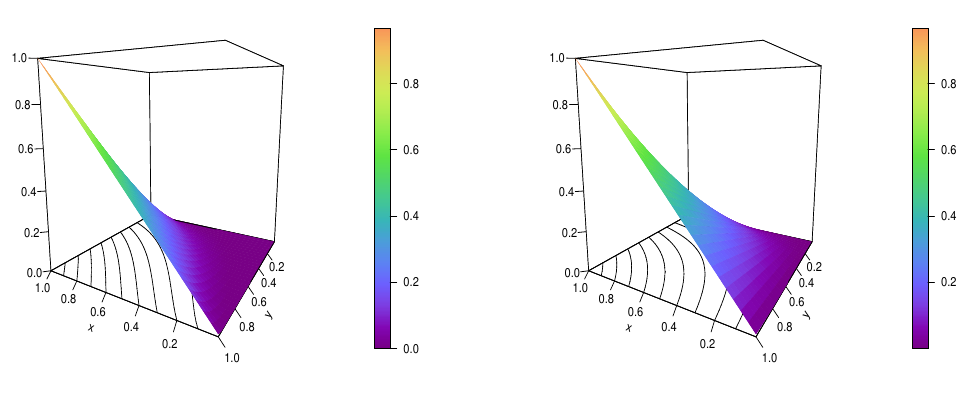
Figure 1. Plots of the TE copula for α = 1/2 ( left ) and α = 20 ( right